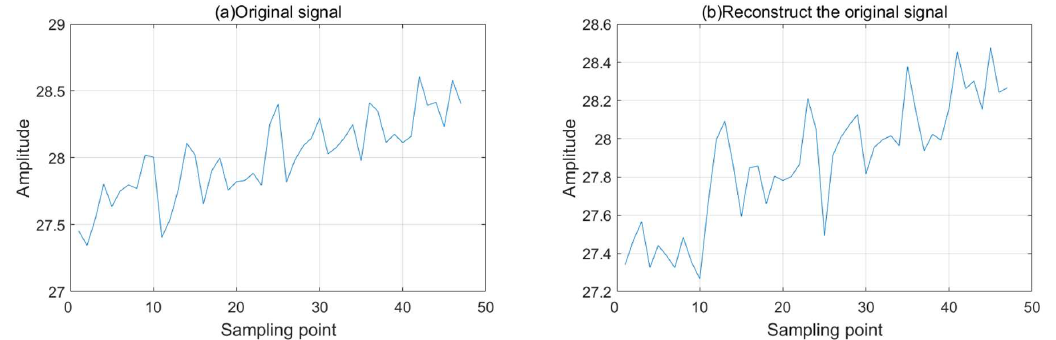
Figure 7. Original and reconstructed SST time series. ( a ) original SST time series; ( b ) reconstructed SST time